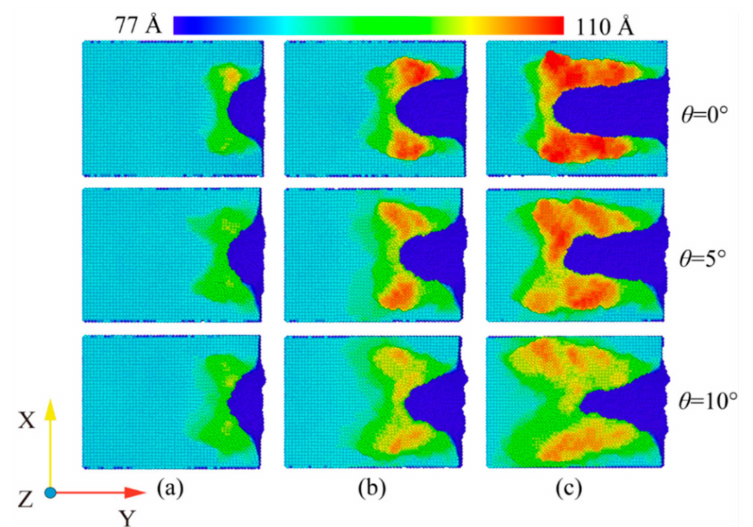
Figure 8. Workpiece surface morphology during dry cutting. ( a ) Cutting distance of 30 Å; ( b ) cutting distance of 60 Å; and ( c ) cutting distance of 100